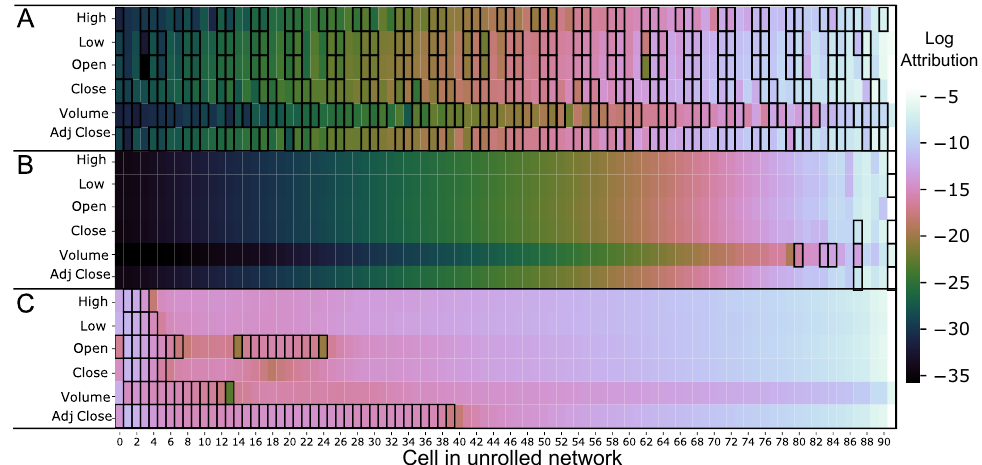
Figure 5. The absolute log attributions for ( A ) RNN, ( B ) LSTM, and ( C ) GRU neural networks. Bordered areas represent negative attributions.